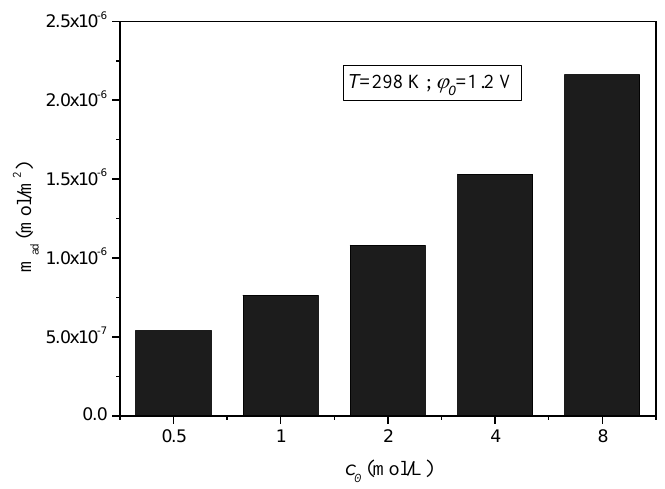
Figure 8. Adsorption capacity variation with different concentrations.